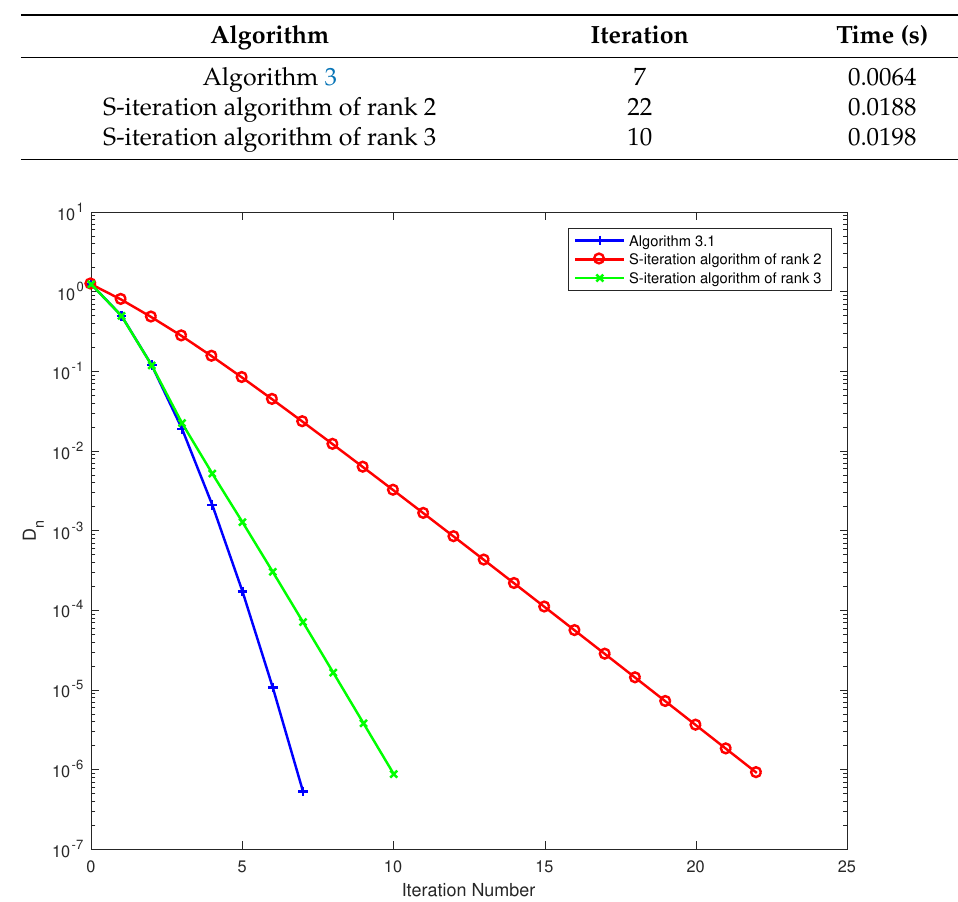
Table 2. Numerical experiments of Example 2.